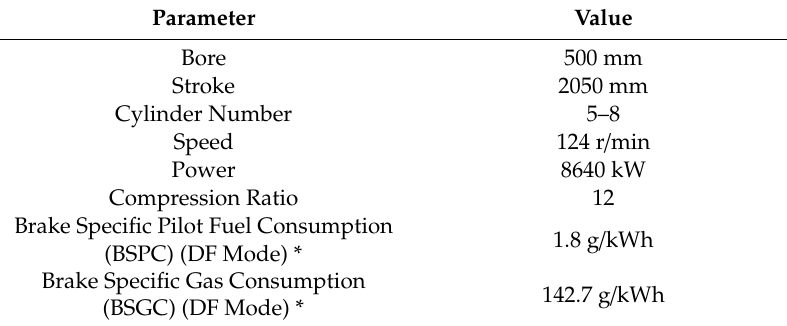
Table 1. WinGD RT-Flex50DF engine dimensions.